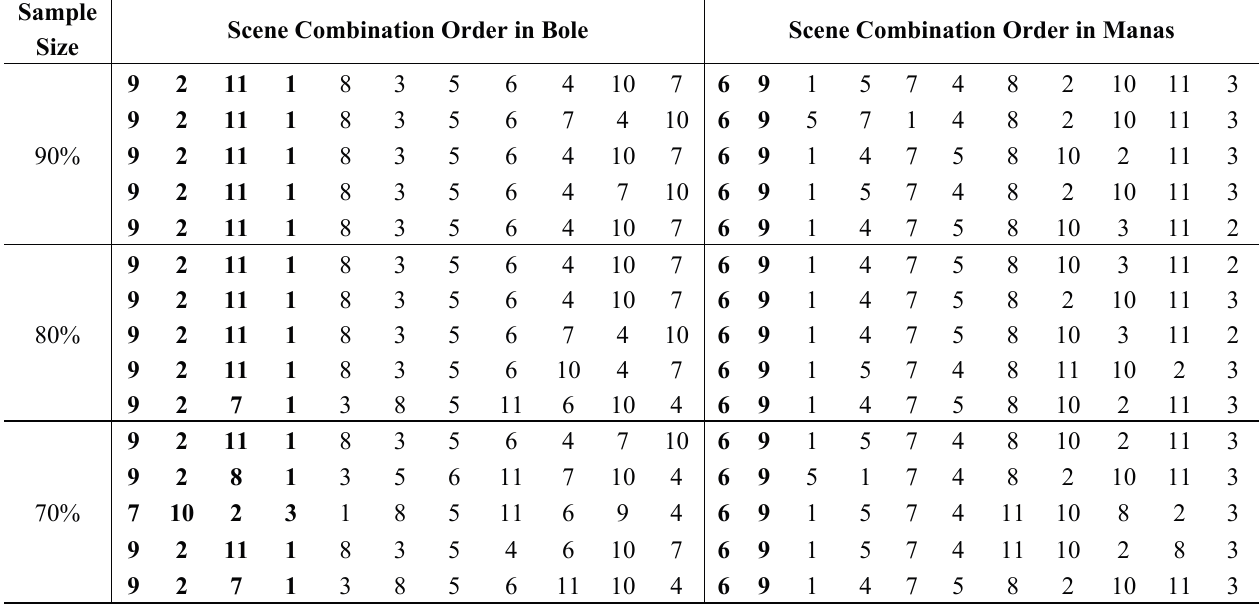
Table 10. Scenes combination order with different sample